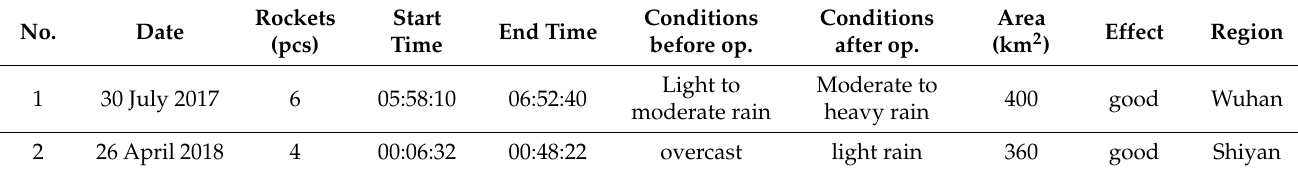
Table 4. Description of information related to artificial precipitation